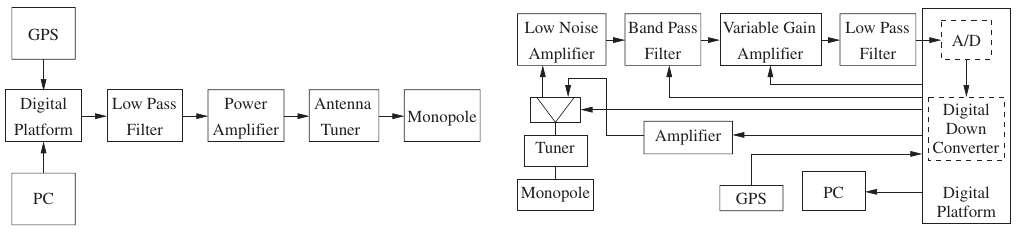
Fig. 5. Transmitter (left frame) and receiver (right frame) used for sounding and data transmission on the HF link. We note that the full transceiver is mainly digital, with only some filtering, amplification and antenna tun- ing performed in the analog